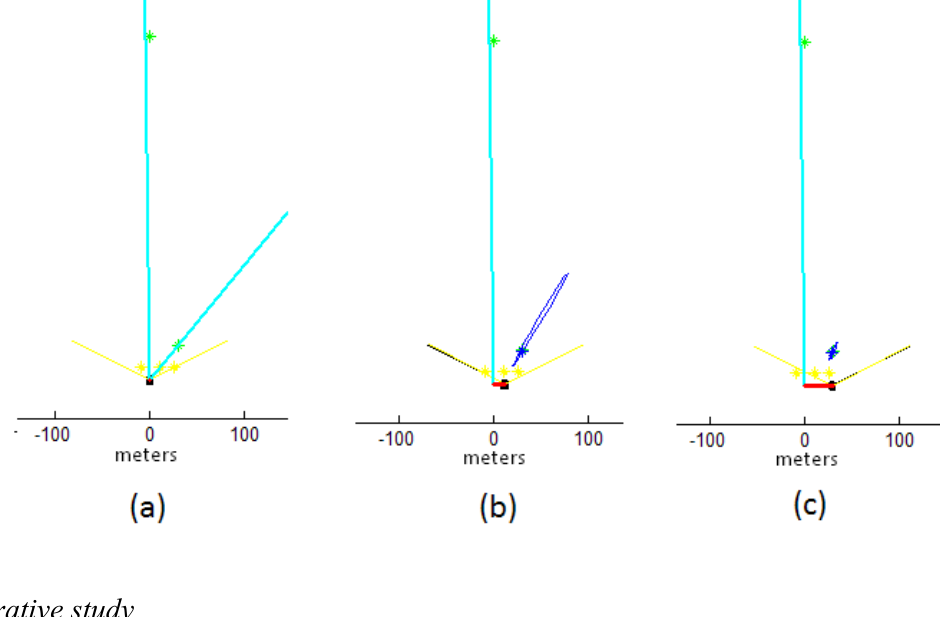
Figure 7. Sequence illustrating the concurrent initialization process: (a) beginning of initialization; (b) initialization process at step 100; (c) initialization process at step